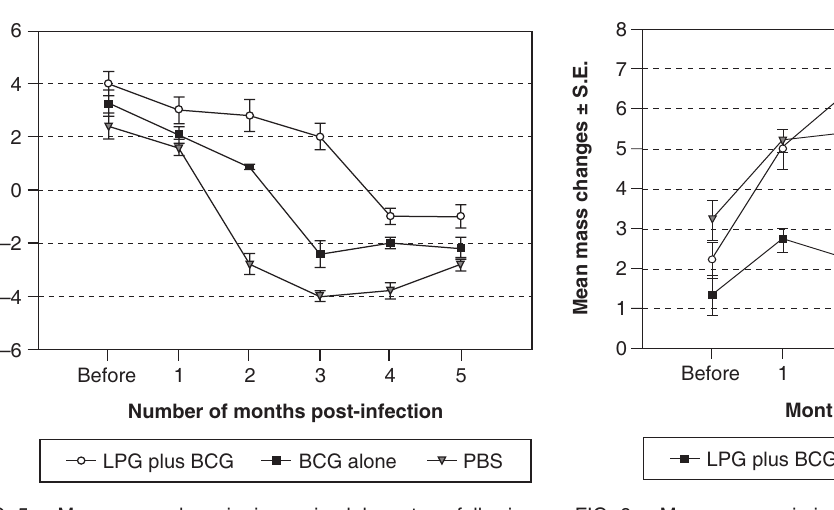
FIG. 5 Mean mass loss in immunized hamsters following challenge with virulent L. donovani